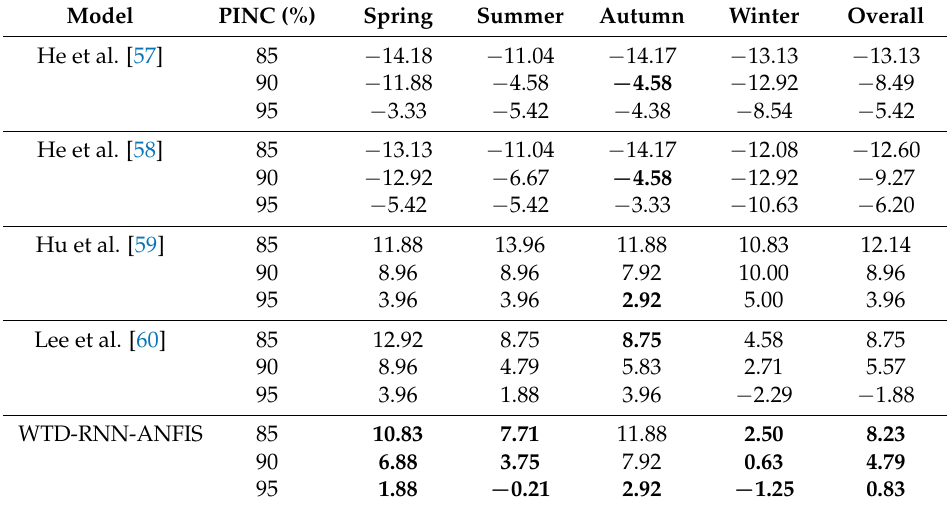
Table 7. Comparisons of the criterion ACE (%) for probabilistic wind speed forecasting. Model PINC (%) Spring Summer Autumn Winter Overall He et al. [57]